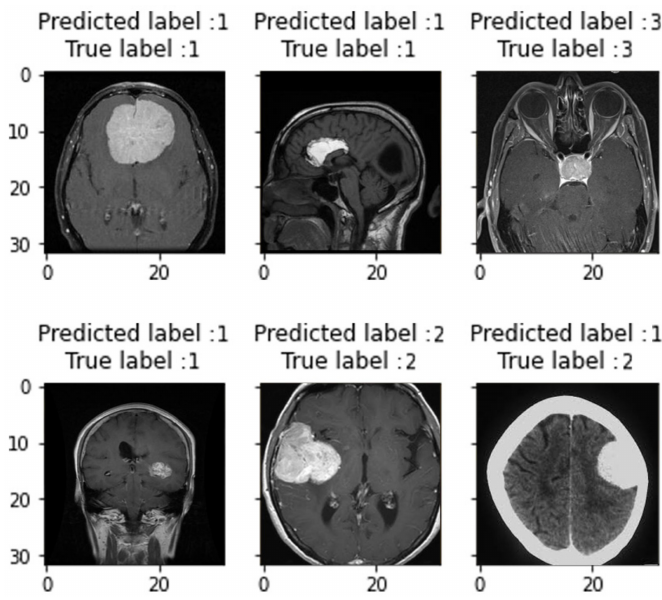
Figure 18. Samples of predicted labels against true labels on unseen